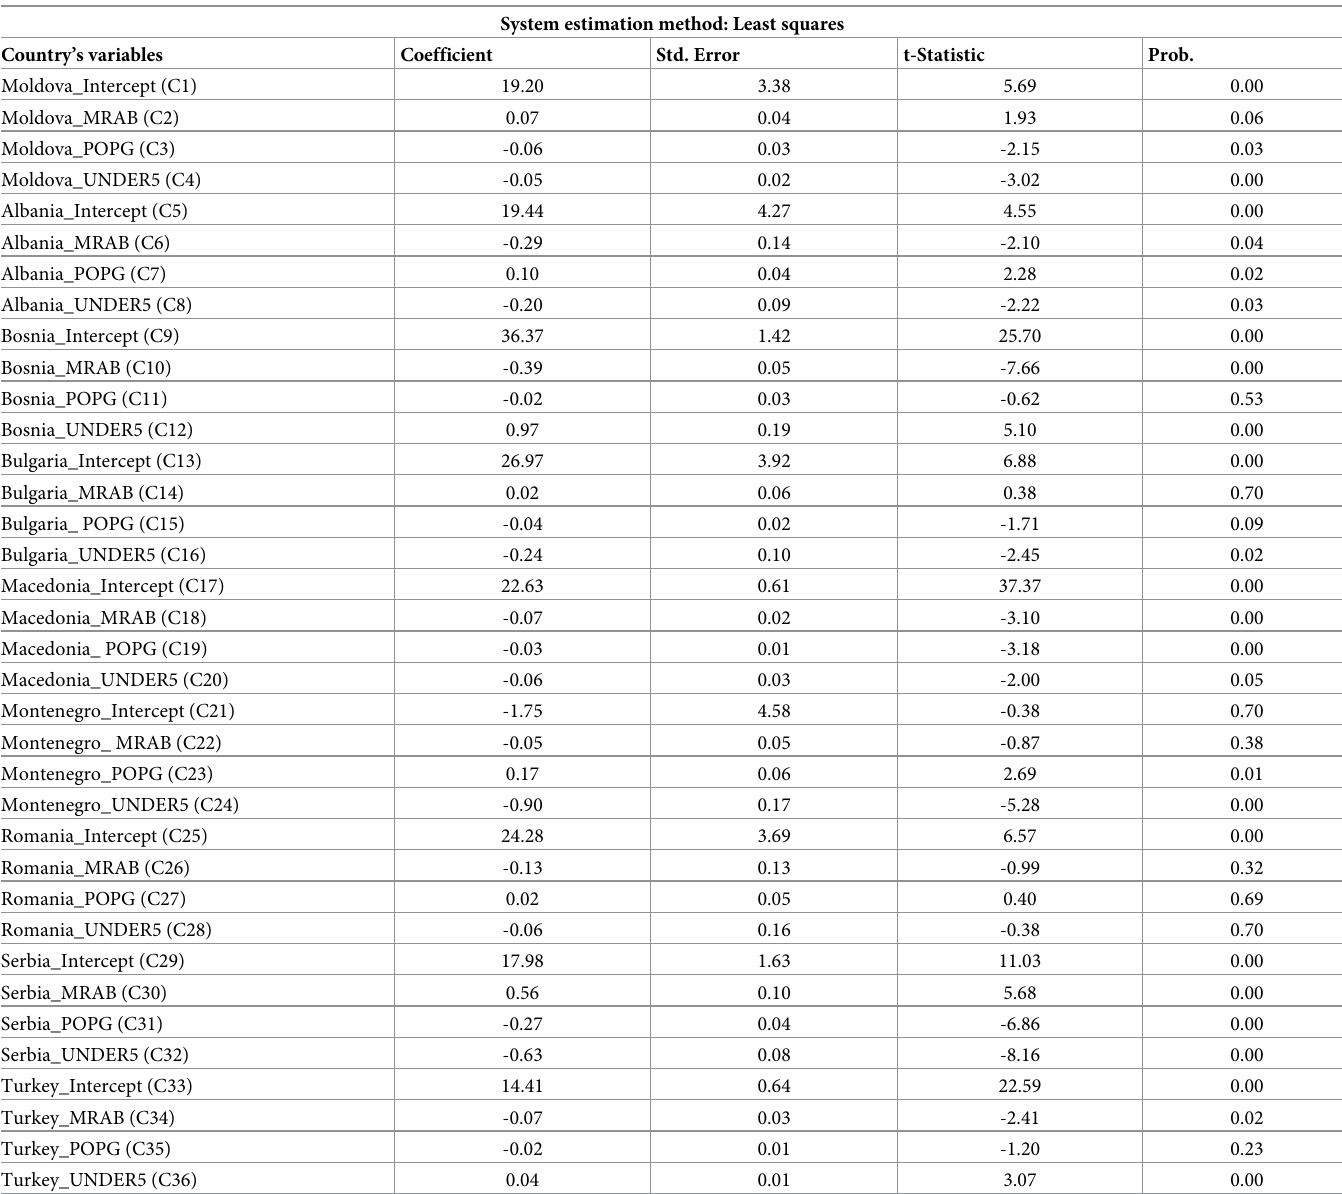
Table 2. System estimation coefficients: Ordinary least squares.